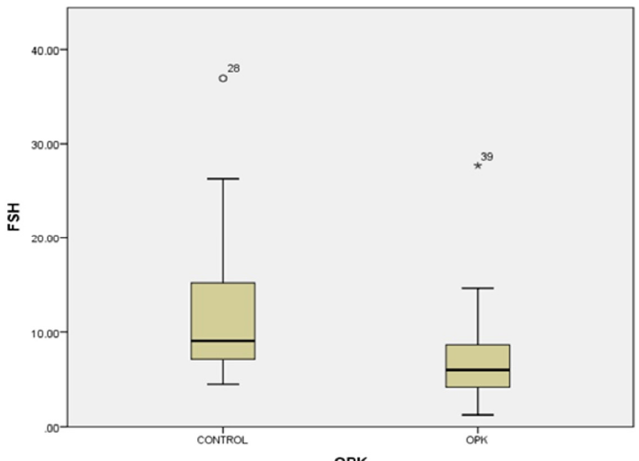
Figure 2. Univariate analysis of the relationship between FSH serum levels and PCOS ( p < 0.005) . Circles represent high potential outliers and the stars represent high extreme values.